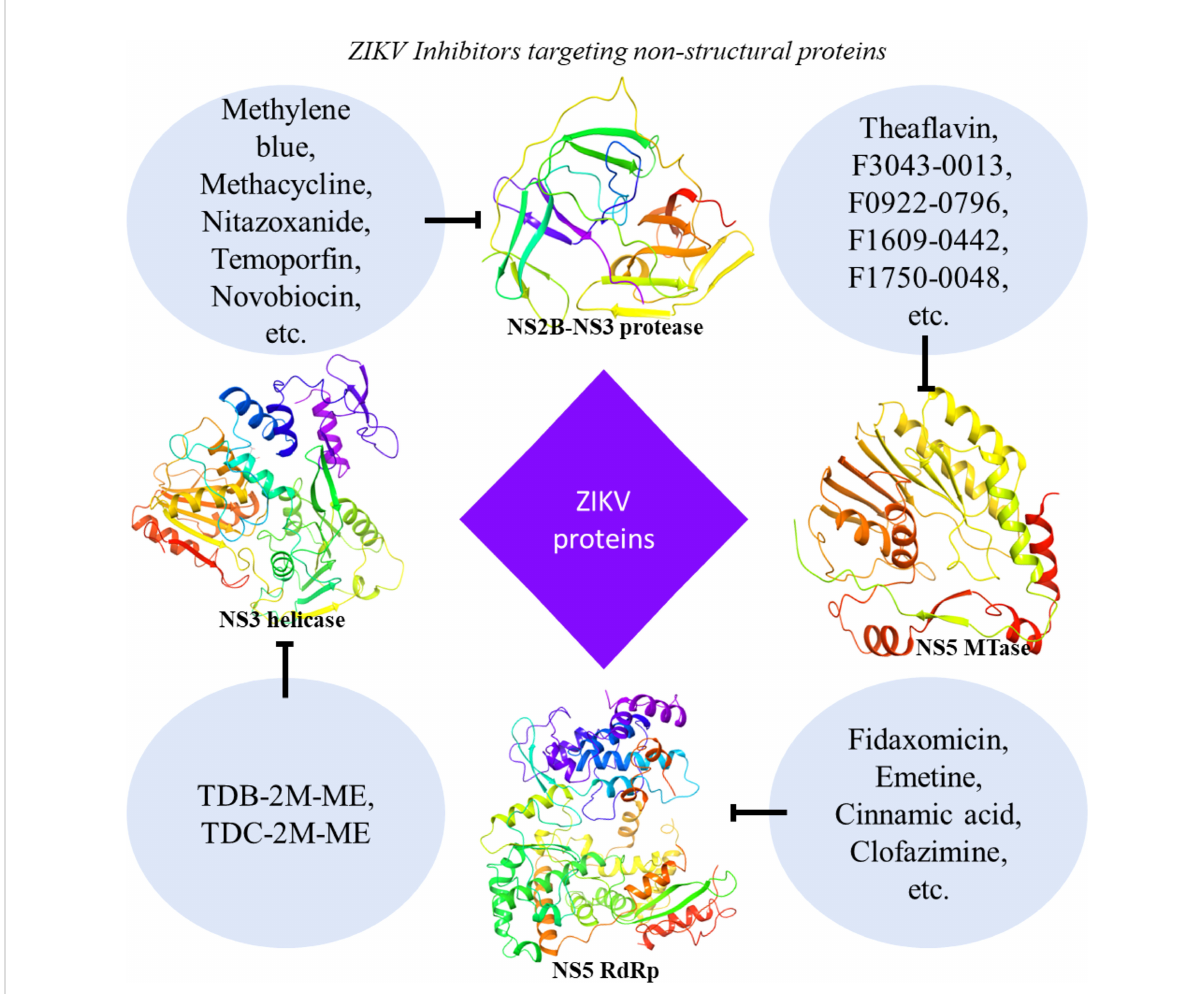
FIGURE 4 ZIKV Inhibitors targeting viral non-structural proteins. Inhibitor molecules, including FDA-approved drugs, natural products, nucleoside analogs, various derivatives, small molecules, and others, show the potential to inhibit ZIKV replication in vitro or in vivo (see Table 2 and Supplementary Tables 1, 2). These molecules target the non-structural (NS2B-NS3 protease, NS3 helicase, RdRp, and MTase) proteins of the ZIKV. Shown protein structures are based on PDB X-ray crystal structures extracted from Maestro software (NS2B-NS3 protease: 5H4I; NS3 helicase: 6MH3; RdRp: 5WZ3; MTase: